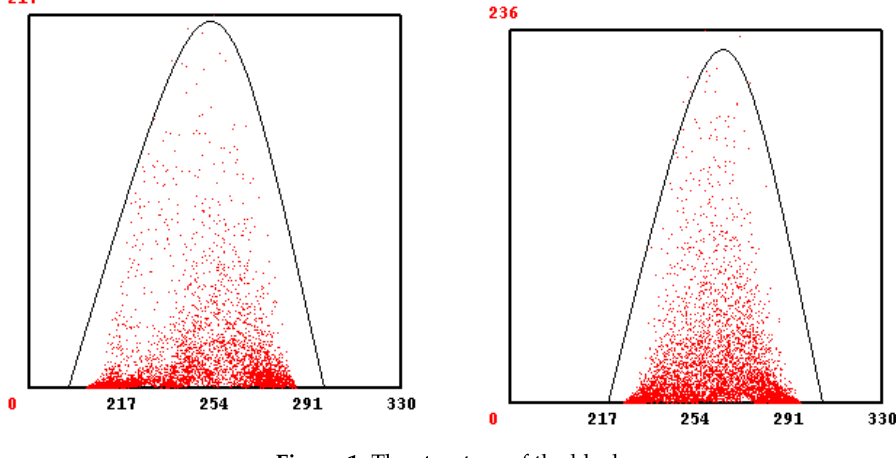
Figure 1. The structure of the block.